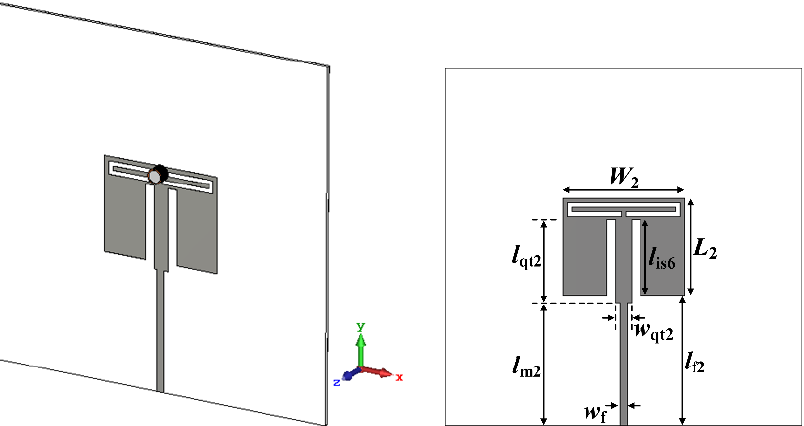
Figure 14. Geometry of the quarter-wave transformer-added scaled radiating edge-aligned SR-CSRR-BCS slot-loaded MPA with the liquid container for liquid MUTs with high relative permittivity and high loss tangent.